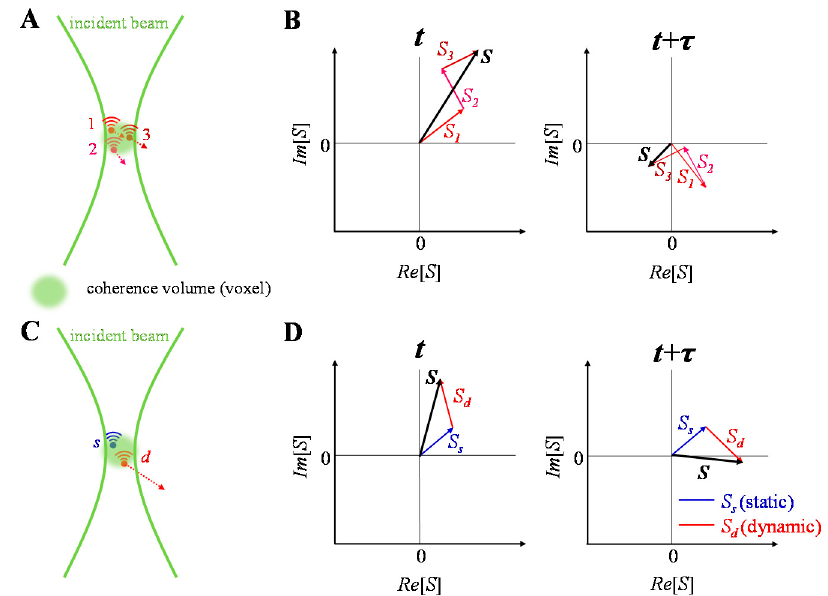
Figure 3. The motion of scatterers in a coherence volume gives rise to complex field fluctuations that form the basis for OCTA signals. The contributions to the complex field are shown at two different points in time (t and t + τ ). ( A , B ) Field fluctuations due to dynamic scatterers in a coherence volume. ( C , D ) Field fluctuations due to a combination of static (blue) and dynamic (red) scatterers in a coherence volume.